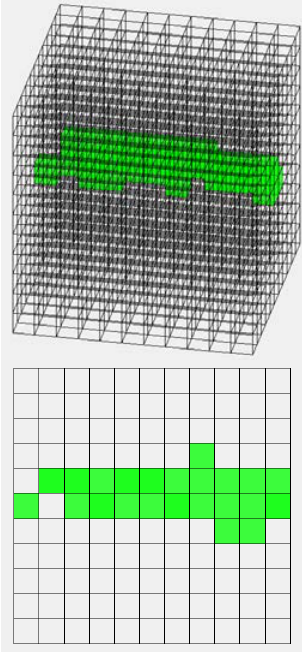
Figure 9. The oblique voxel representation (left image) and the Figure 11. The oblique voxel representation (upper image) and top view (right image) of the imaging geometry in the second the top view (lower image) of the XYZ buffer in the second test test case.